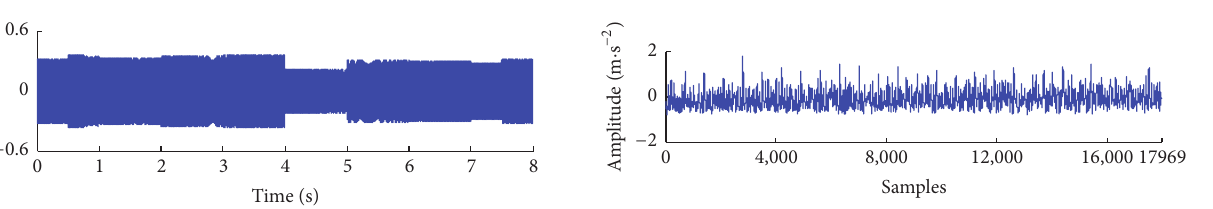
Figure 8: The envelope signal of the equiangular resampling signal.